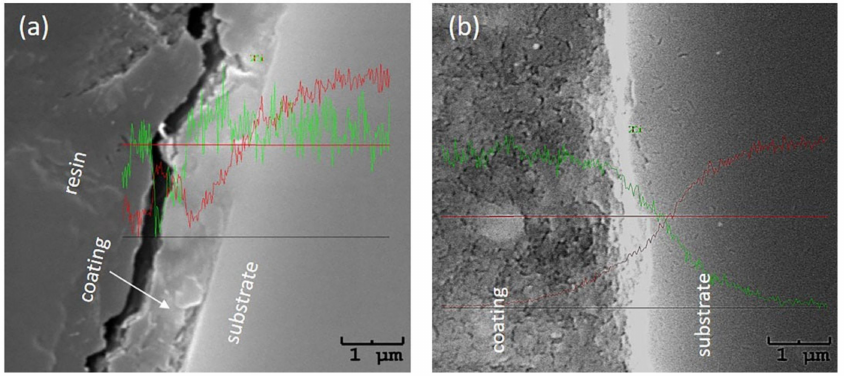
Figure 7. Linear analysis of the distribution of elements for obtained coatings. Scale bar = 1 µ m; ( a ) Ti_10_100; ( b )